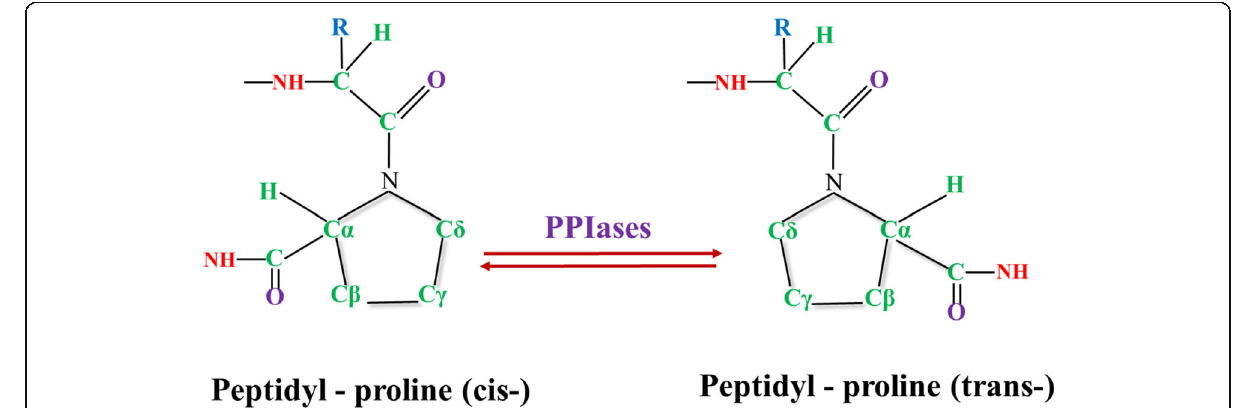
Fig. 3 Conversion of cis- and trans- forms of proline by